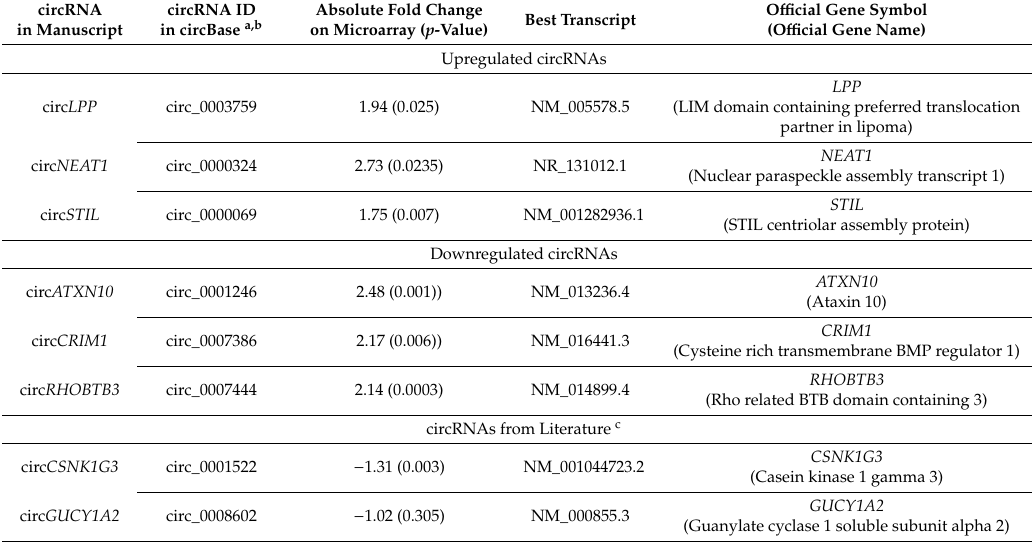
Table 2. List of circular RNAs (circRNAs) seleceted for further evaluation in this study based on their di ff erential expression between malignant and adjacent normal tissue samples data in the microarray discovery study phase and literature search.